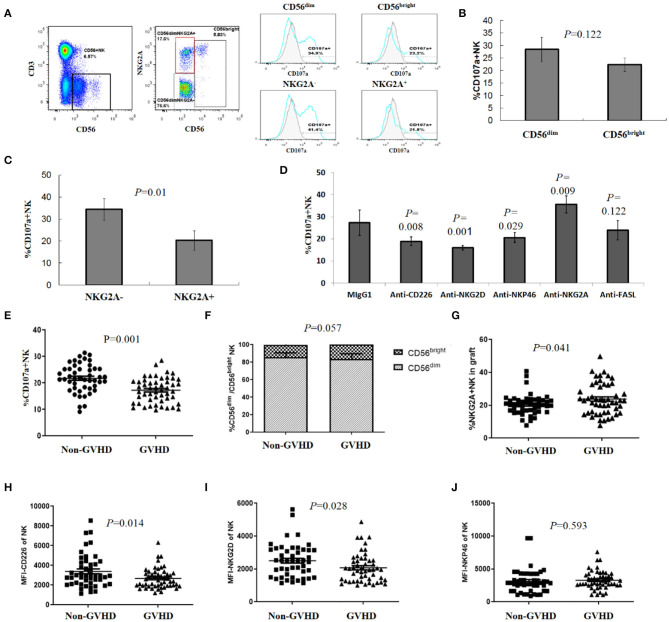
Subgroup and receptor expression of donor NK cells affected NK degranulation toward activated T cells associated with aGVHD. (A) Representative gating strategy. CD56dim and CD56bright NK cells were gated and subsets were defined based on the expression of NKG2A, the percentage of CD107a positive cells was analyzed on each subset of NK cells. (B) CD107a expression in CD56dim and CD56bright NK cells (n = 4), (C) CD107a expression in NKG2A− and NKG2A+ subgroups (n = 4), (D) NK cells were pretreated with neutralizing antibodies (or relevant isotype-matched Ig controls) before degranulation assay (n = 4). (E) Levels of donor NK degranulation toward activated T cells were significantly lower in the aGVHD group than in the non-aGVHD group (P = 0.001, n = 98). Percentage of CD56dim and CD56bright NK cells (F), NKG2A+ NK cells (G) in allografts from the aGVHD and non-aGVHD groups (n = 98). MFI of CD226 (H); NKG2D (I) and NKP46 (J) of NK cells in allografts from aGVHD and non-aGVHD groups (n = 98). All calculated averages were defined as the parametric mean ± SD. Student's t-tests or two-way ANOVA analyses were used to compare the mean among groups.